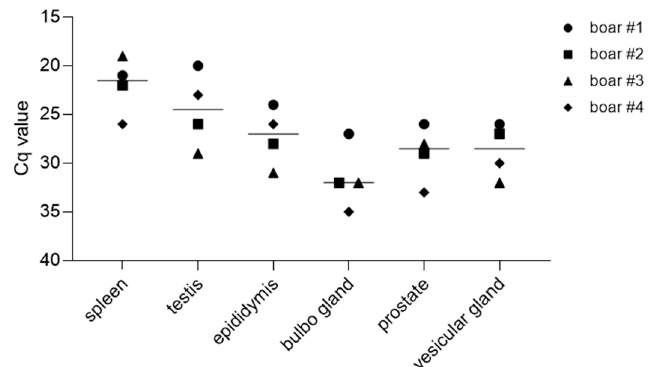
Figure 9. ASFV genome detection in organs of the reproductive tract of boars. Genome loads were evaluated by qPCR. Lines display the group median; each individual is represented by a symbol.